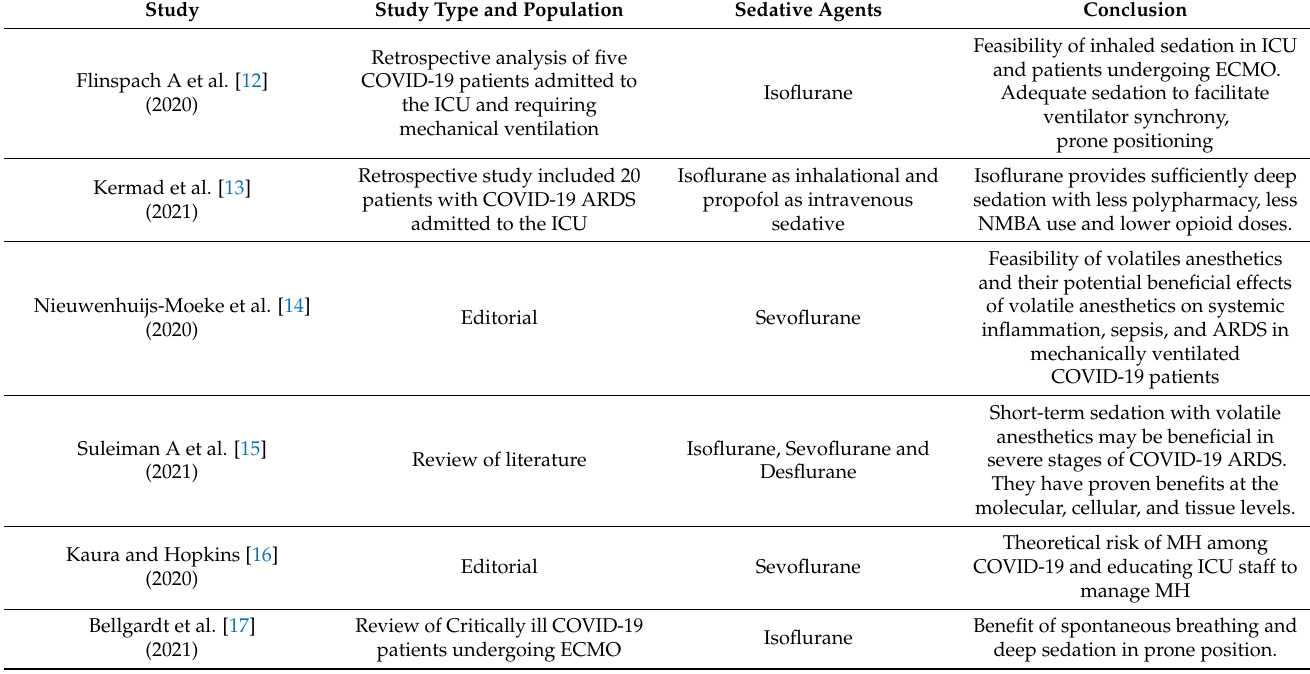
Table 1. Published studies in chronological on sedating COVID-19 mechanically ventilated patients with volatile anesthetic agents.